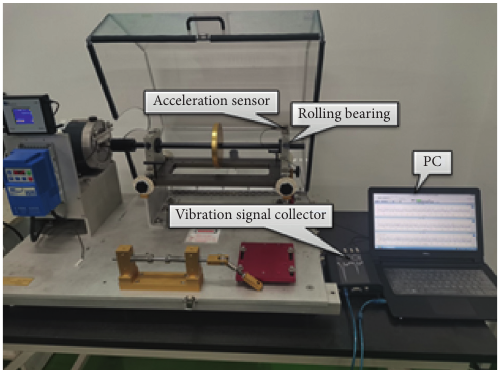
Figure 11: Comprehensive mechanical failure simulation test bench.